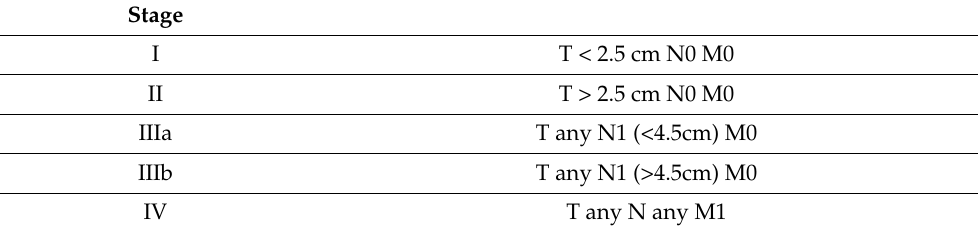
Table 1. Clinical staging scheme for dogs with AGASACA.